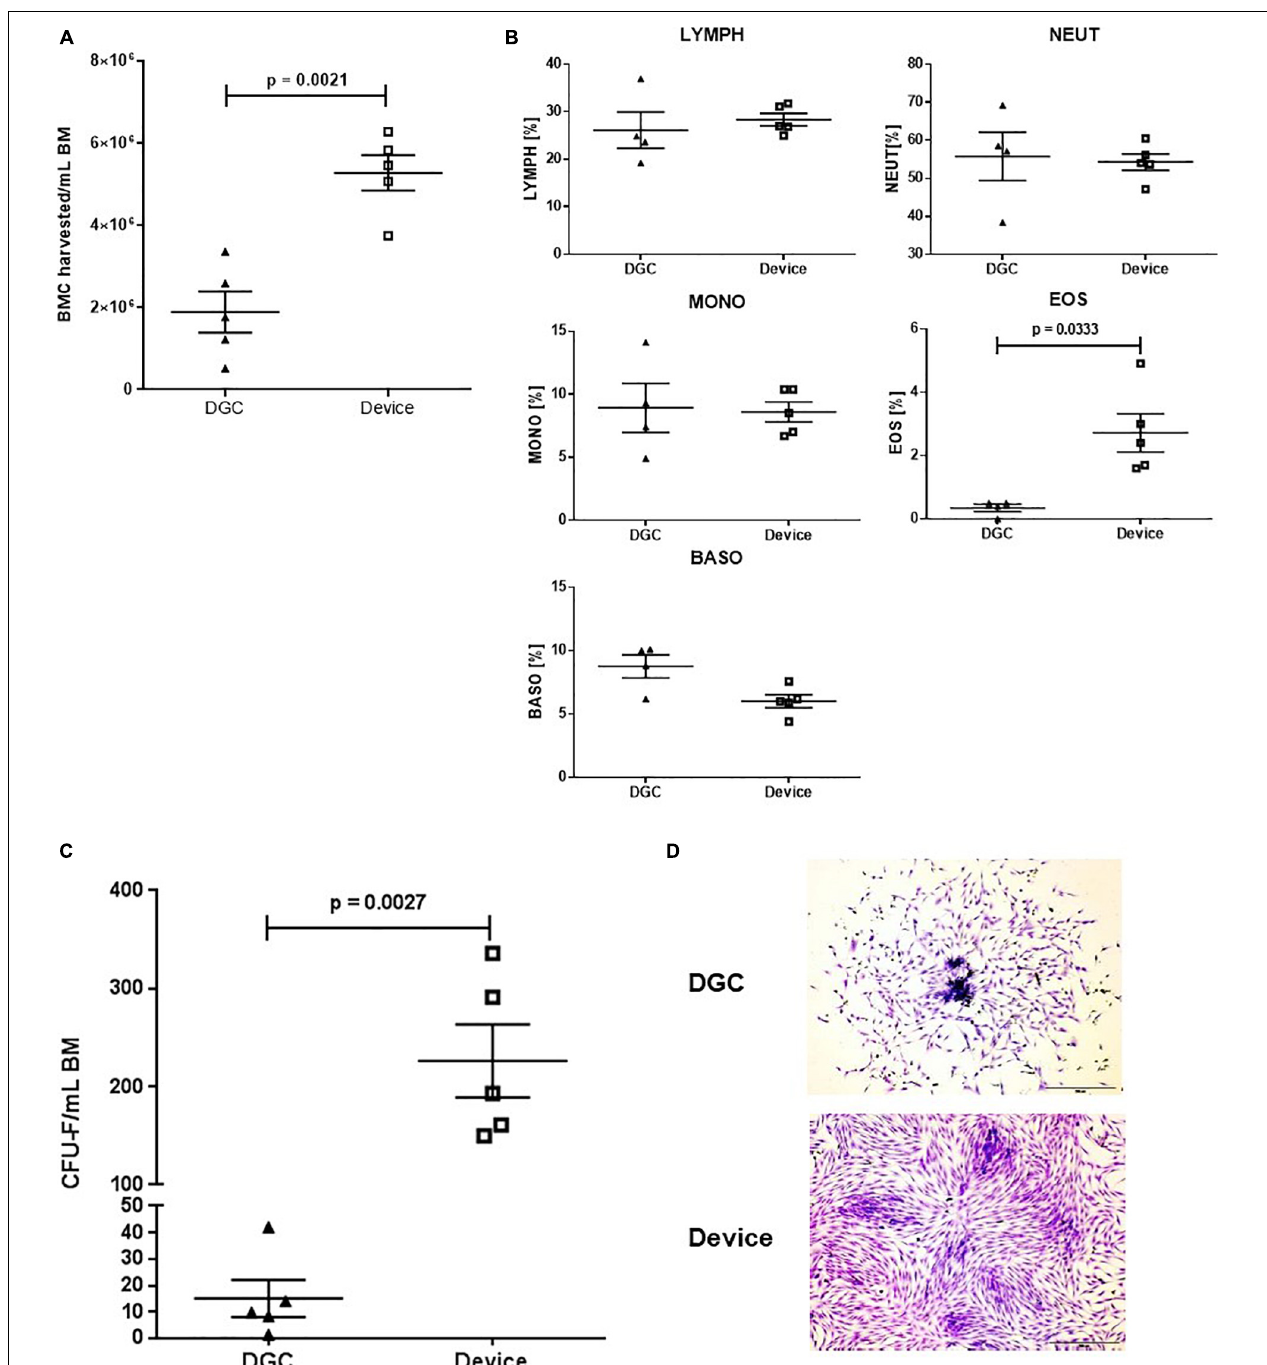
FIGURE 2 | CFU-F content and growth. BMC harvested per mL BM processed with the device and by DGC (A) and white blood cell subsets of the cell suspensions (B) . Each data point represents one donor ( n = 5 donors). Error bars: SEM. Paired t -test. CFU-F content per mL BM in MSCs isolated with the device and isolated by DGC at P0 (C) . Each data point represents one donor (n = 5 donors) as mean of two technical replicates. Error bars: SEM. Paired t -test. Representative microphotographs show CFU-F from both groups (D) . Crystal violet staining. Original magnification × 4; scale bar: 100 µ